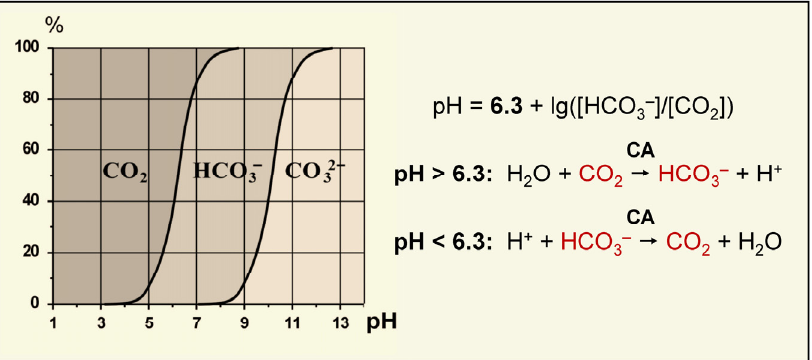
Figure 3. The concentration ratio and pH dependence of C i forms in water solutions [65]; the Henderson–Hasselbach equation for [CO 2 ]/[HCO 3 − ] ratio; and the preferential direction of the reaction ensured by CA as a function of pH.